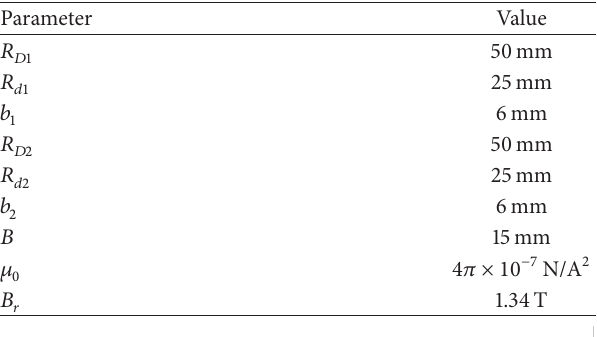
Table 1: Parameters for numerical simulation of magnetic force and stiffness.